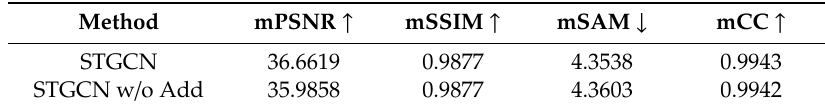
Table 8. Quantitative evaluation of cloud removal algorithms with and without add operation in each block. w / o is short for